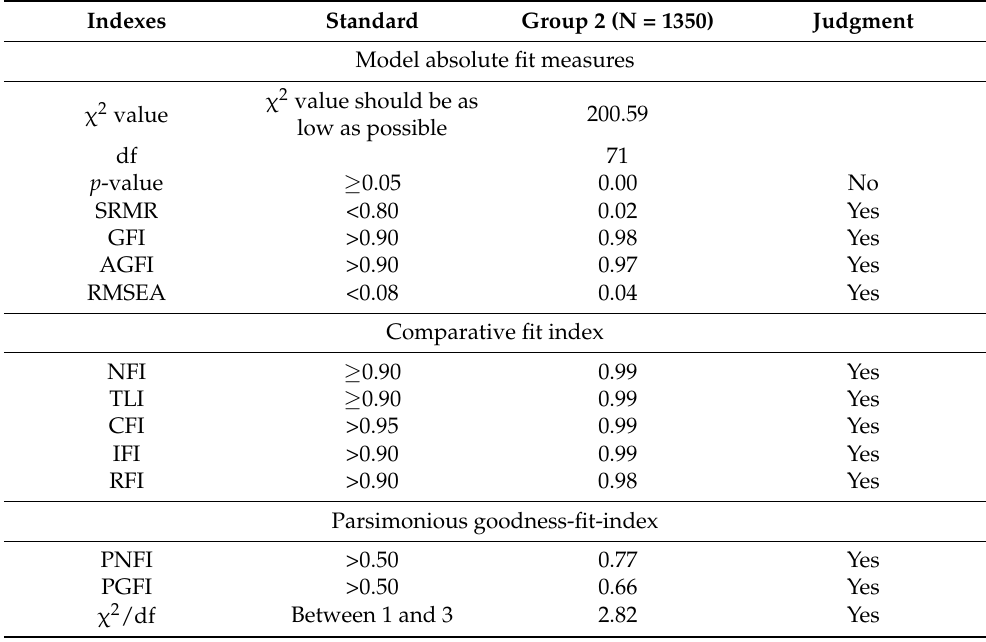
Table 5. The Goodness of Fit Indexes of Recreational Sport Well-being Scale.